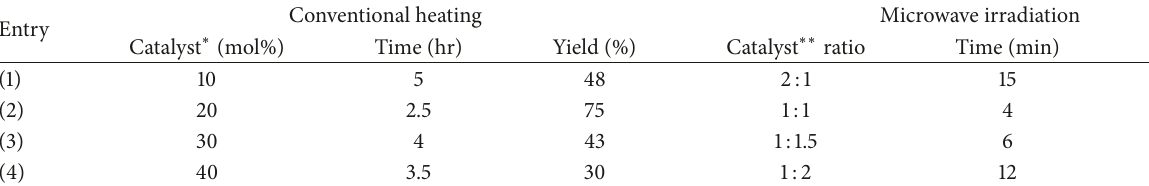
Table 3: Optimization of reaction conditions.